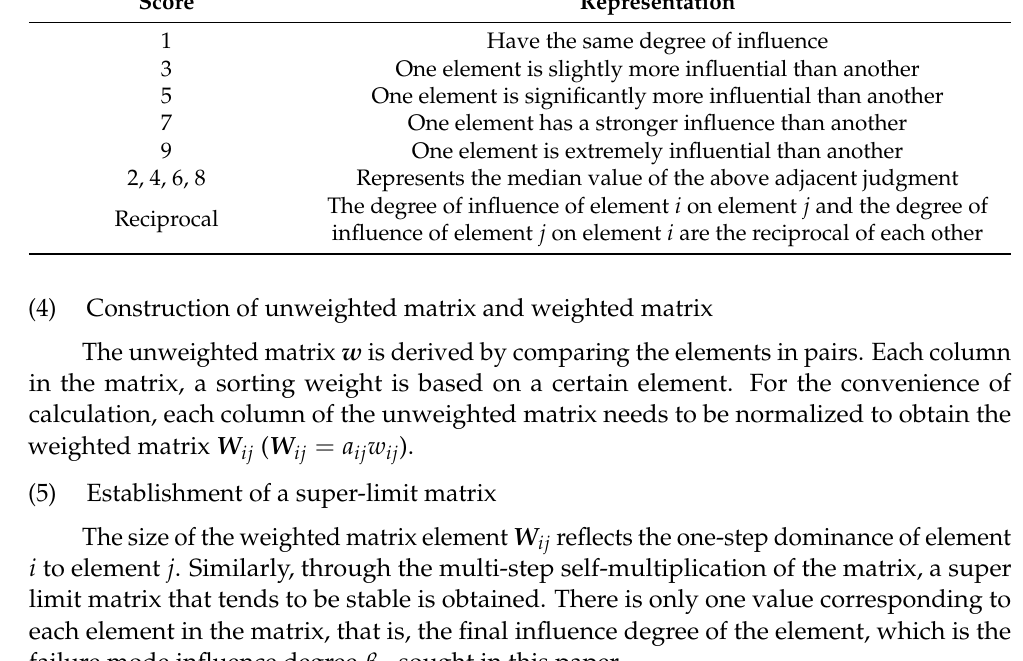
Table 1. 1–9 scale scoring method. Score Representation 1 Have the same degree of influence 3 One element is slightly more influential than another 5 One element is significantly more influential than another 7 One element has a stronger influence than another 9 One element is extremely influential than another 2, 4, 6, 8 Represents the median value of the above adjacent judgment The degree of influence of element i on element j and the degree Reciprocal